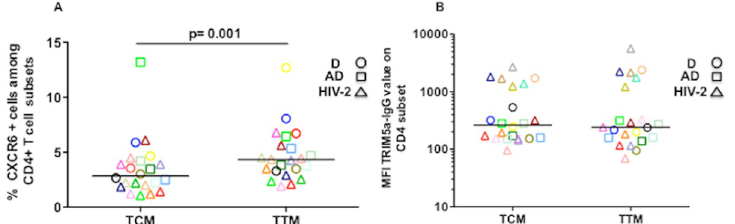
Fig 8. Flow-cytometry analysis of CXCR6 and TRIM5 α proteic expression in TCM and TTM CD4+ T cells Flow cytometry analysis of central-memory (TCM; CD45RA-CCR7+CD27+) and in transitional memory (TTM; CD45RA-CCR7-CD27+) CD4+ T-cells subsets from 12 HIV-2 infected subjects (open triangle), 4 donors (D) (open dot) and 5 West-African donors (AD) (open squares) showing the A) Cell surface expression of CXCR6. B) Mean fluorescence intensity (MFI) of intra-cellular TRIM5 α after subtracting the secondary immunoglobulin MFI. Each symbol represents a subject and the medians are shown.